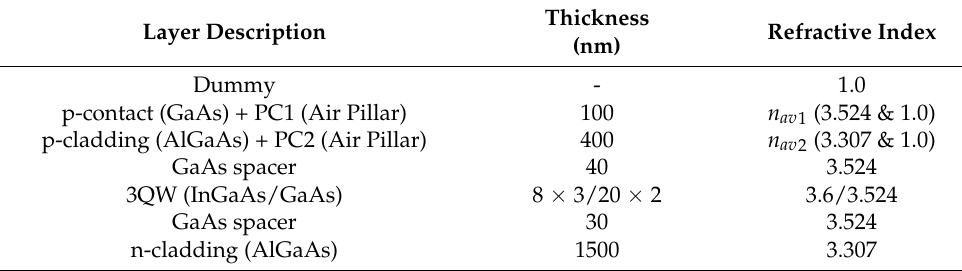
Table 2. The simulated layer structure of air-pillar